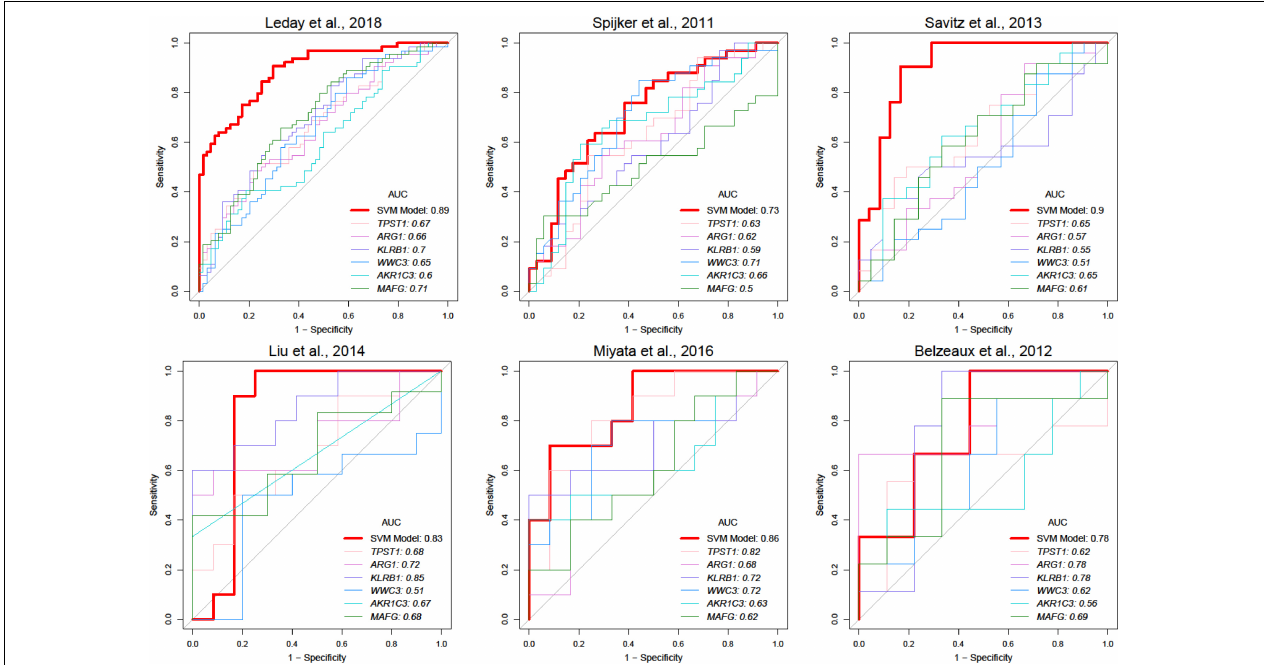
FIGURE 4 | Comparison of prediction performance between SVM and single-gene models. Red lines represent ROC curves of SVM model in different studies, and lines with other colors represent ROC curves of various single gene